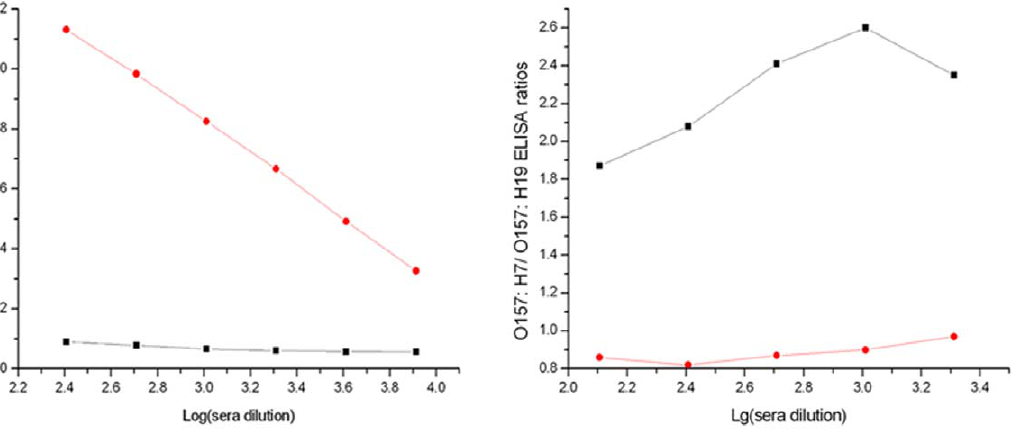
Figure 1. Immune suppression of E.col i O157:H19 on day 55 and enhancement of immune response to E.coli O157:H7 on day 89 by Cy-mediated subtractive immunization procedure. A, sera from Cy-treated mice (experimental group) and no Cy-treated mice (control group) N were diluted and tested for antibody reactivity to E. coli O157:H19 in whole cell ELISA (OD 450 nm); B, sera were diluted and tested for reactivity to : control group). E. coli O157:H7 and E. coli O157:H19 ( & : experimental group;